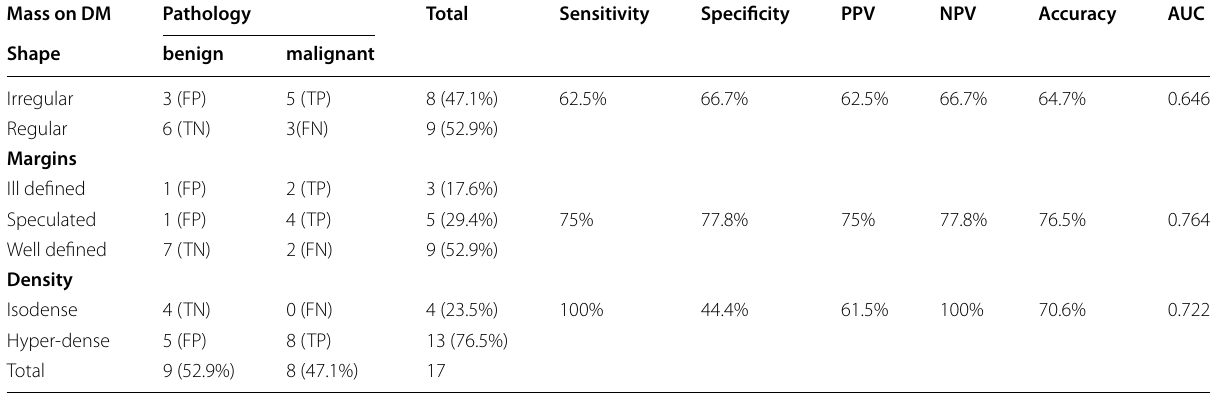
Table 4 Diagnostic performance of DM in characterization of breast masses according to shape, margins and density Mass on